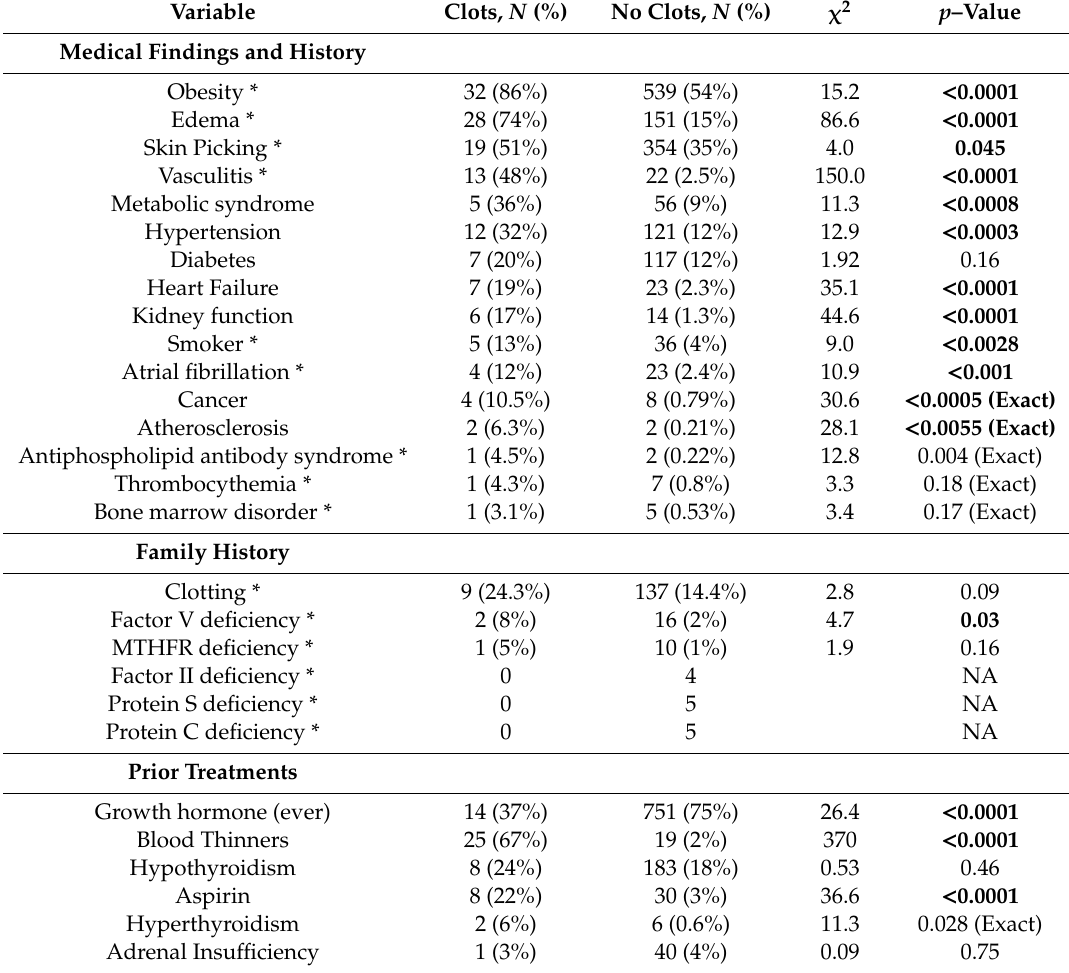
Table 2. Frequency and analysis of risk factors for thromboembolism in Prader–Willi